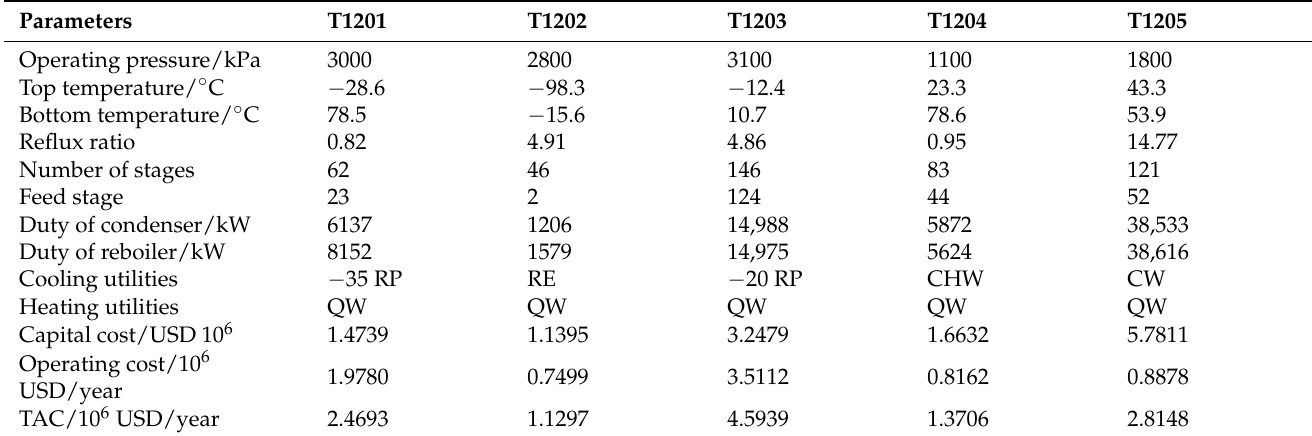
Table 6. Optimal parameters of columns.